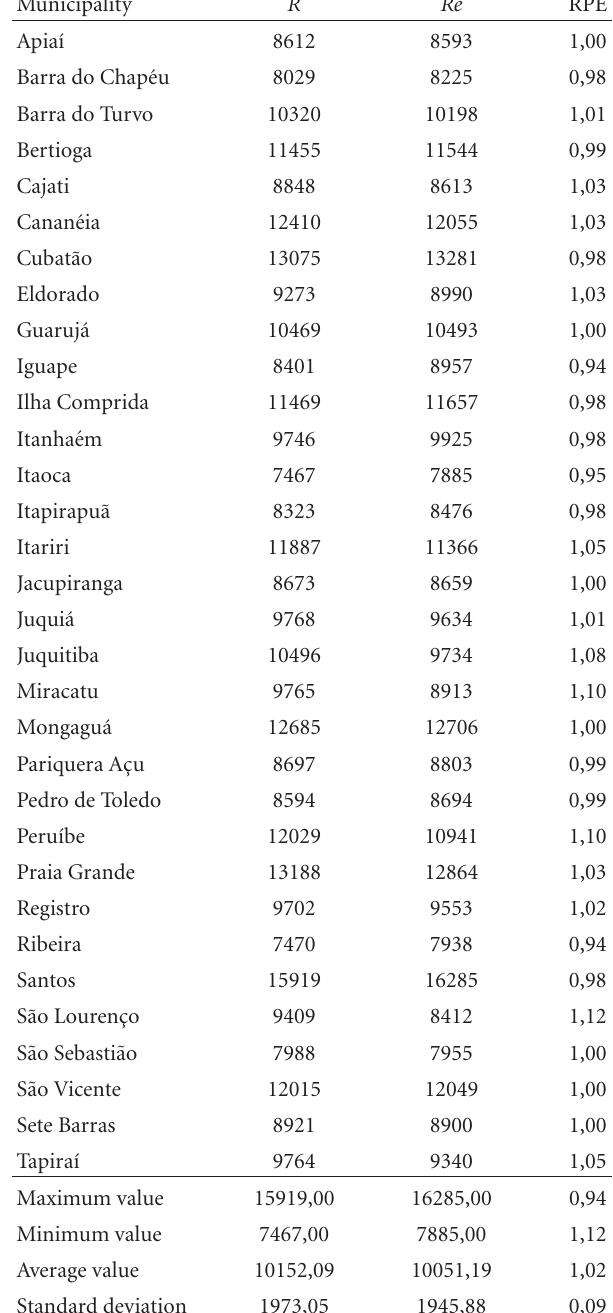
Table 3: Results of the estimation of rainfall erosivity ( R ) according to [8] (MJmm (h ha) − 1 ), of the estimation with the use of the equation obtained with the use of artificial neural networks ( Re ) (MJmm (h ha) − 1 ), and of the relative percentage error (RPE) in module between the erosivity values R and Re , in %, for the 32 municipalities in the Ribeira Valley and Coastal region of the State of S˜ao